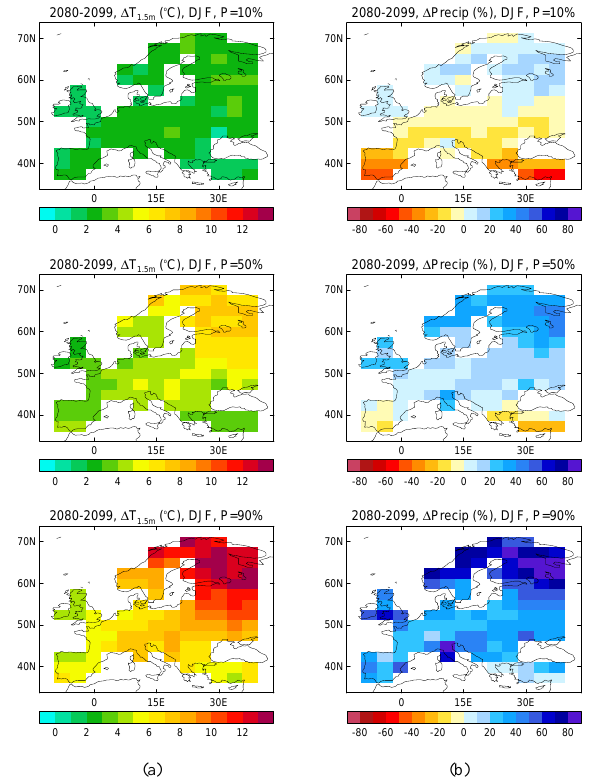
PDF for: (a) European surface temperature change; (b) European percentage precipitation change, for the winter season for the period 2080–2099 relative to the 1961–1990 baseline